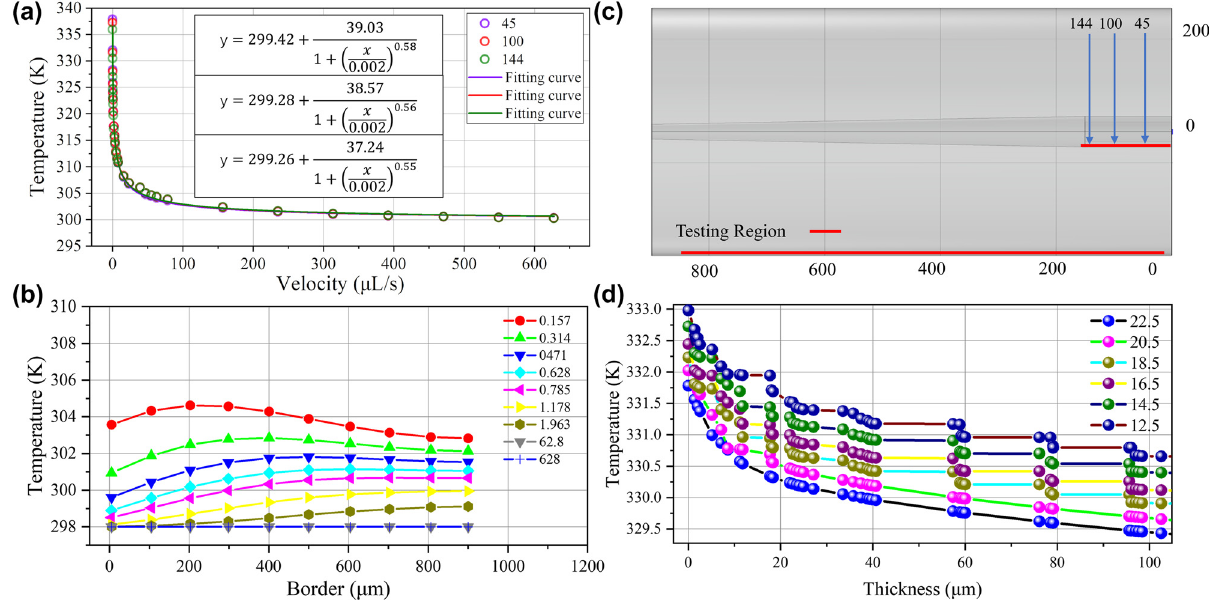
Figure 5: Simulation results of the flowmeter: (a) Temperature variation and fitting curve at three points of the central axis of side wall under different flow rate. (b) Temperature variation along the boundary of fluid and air under different flow rate. (c) Sample point. (d) Steady-state temperature along the central axis versus thickness of sidewall (superficial area) under flow rate of 0.314 μ